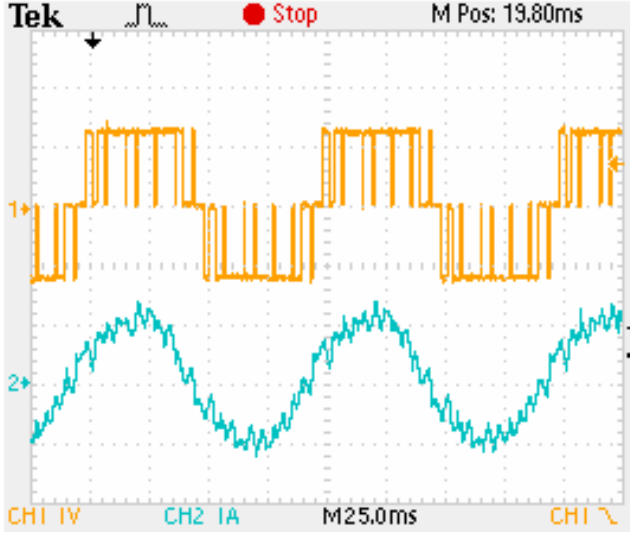
Figure 16. a-phase switching pulse and stator current waveform of motor in steady state. As the forward rotation speed of 1000 rpm was maintained, the speed and torque waveforms of EESM during sudden load addition and sudden load reduction are shown in Figure 17. The green-blue line at the top of the figure below is the speed, while the dark blue line at the bottom is the torque. The increase in torque indicates loading and the de- crease represents load reduction. The embodiment of the control effect can be clearly seen from the stability of the speed kept during loading and unloading. Figure 17. Dynamic load addition and load reduction process of EESM at low switching frequency, CH1: speed waveform; CH2: torque waveform. 5. Conclusions In order to improve the dynamic speed regulation performance of an EESM at low switching frequency, the following work has been carried out in this paper: 1) the EESM is modeled based on a complex matrix, which simplifies the model and reveals the internal electromagnetic structure of the system; 2) taking the stator flux linkage as the tracking target, the rolling time domain optimization theory is combined with the optimized PWM strategy to realize the dynamic adjustment of the motor through the dynamic adjustment